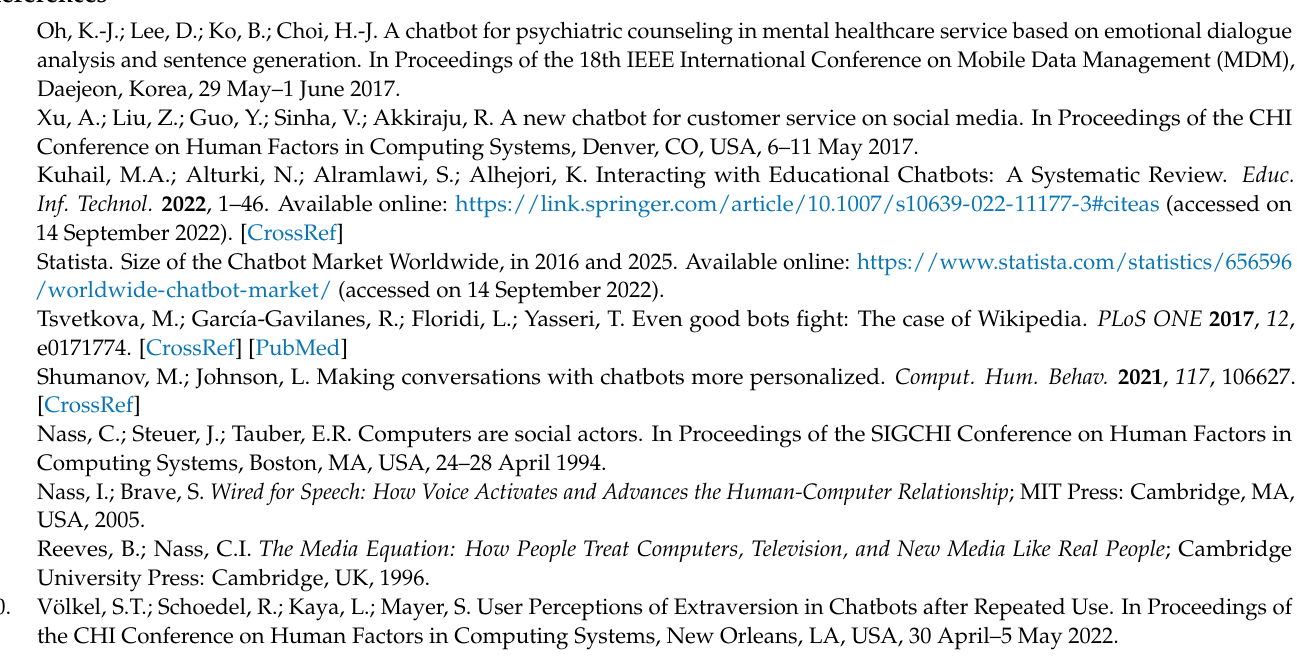
Figure A3. Students’ reasons for preferring certain Figure A3. Students ’ reasons for preferring certain chatbots. Figure A3. Students ’ reasons for preferring certain chatbots.